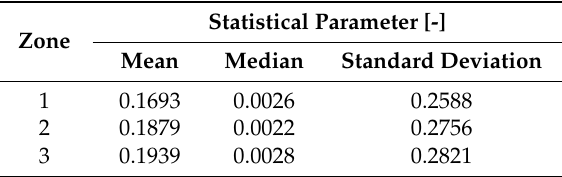
Table 1. Statistical properties of the PV data